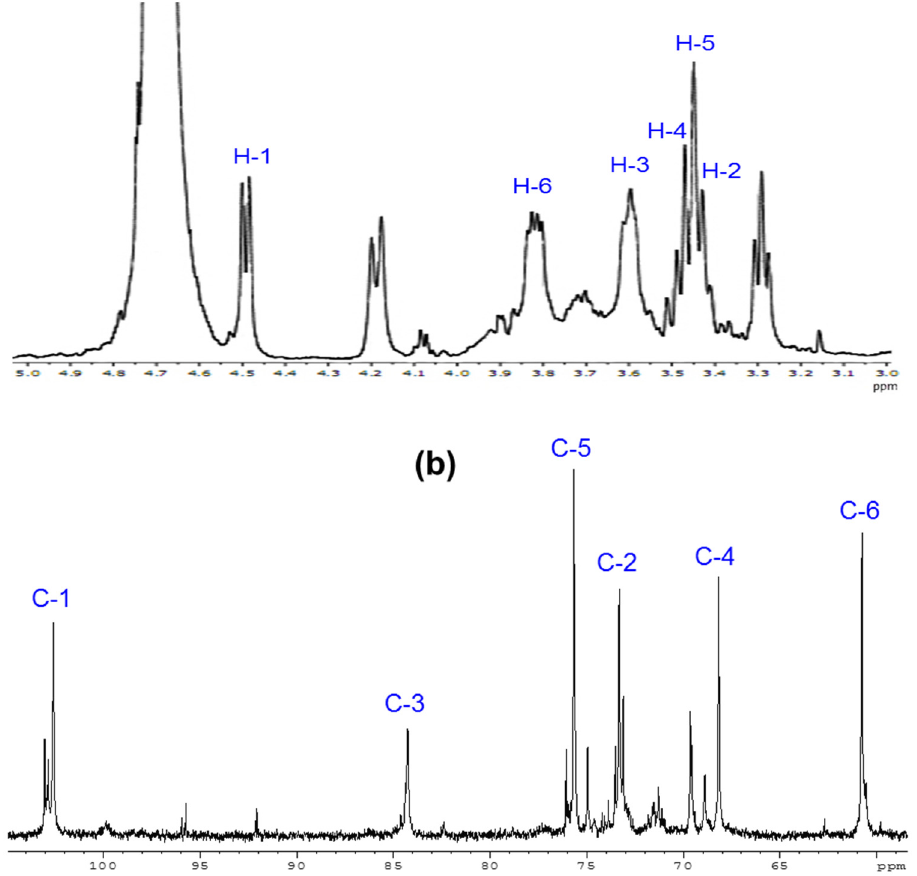
Figure 4. The 1 H ( a ) and 13 C nuclear magnetic resonance (NMR) ( b ) spectra of degraded β -glucan with molecular weight of about 25 kDa.